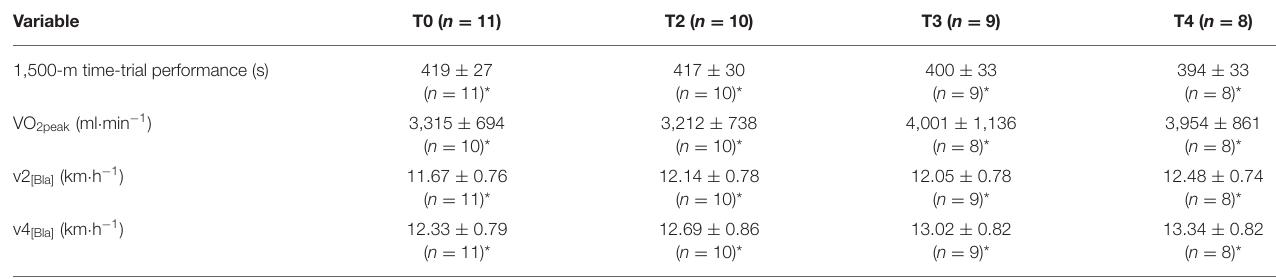
TABLE 4 | Physiological characteristics and parameters related to performance at the four time-points for testing. Variable T0 ( n = 11)